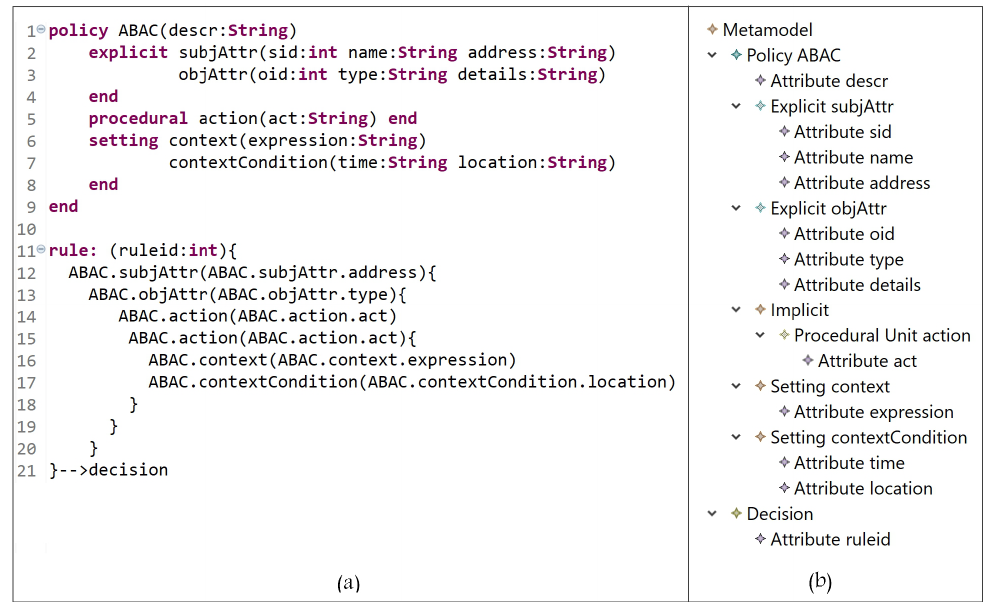
Figure 13. ( a ) ABAC policy definition; ( b ) ABAC